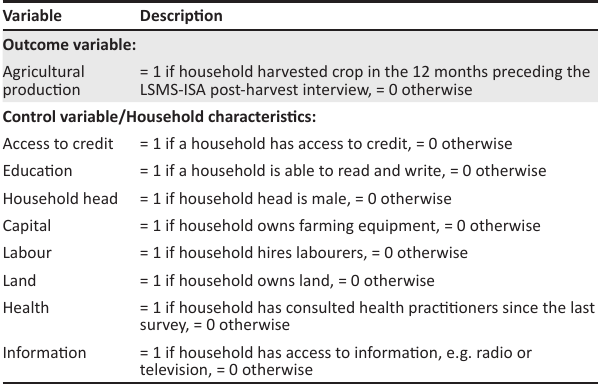
TABLE 1: Description of